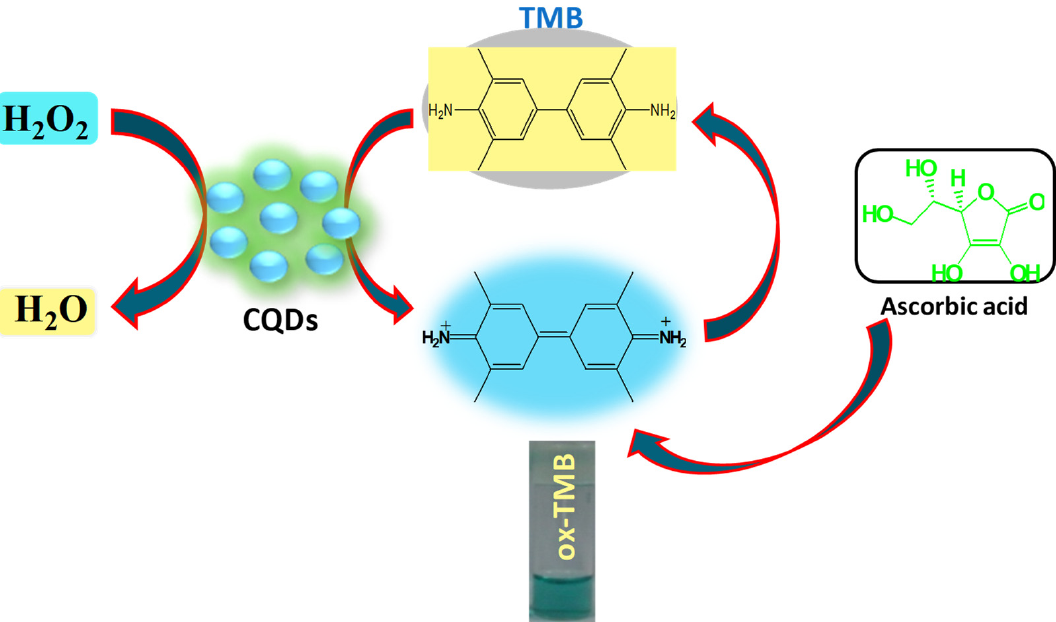
Figure 7. Showing the oxidation of TMB along with H 2 O 2 in the presence of CQDs as a catalyst.